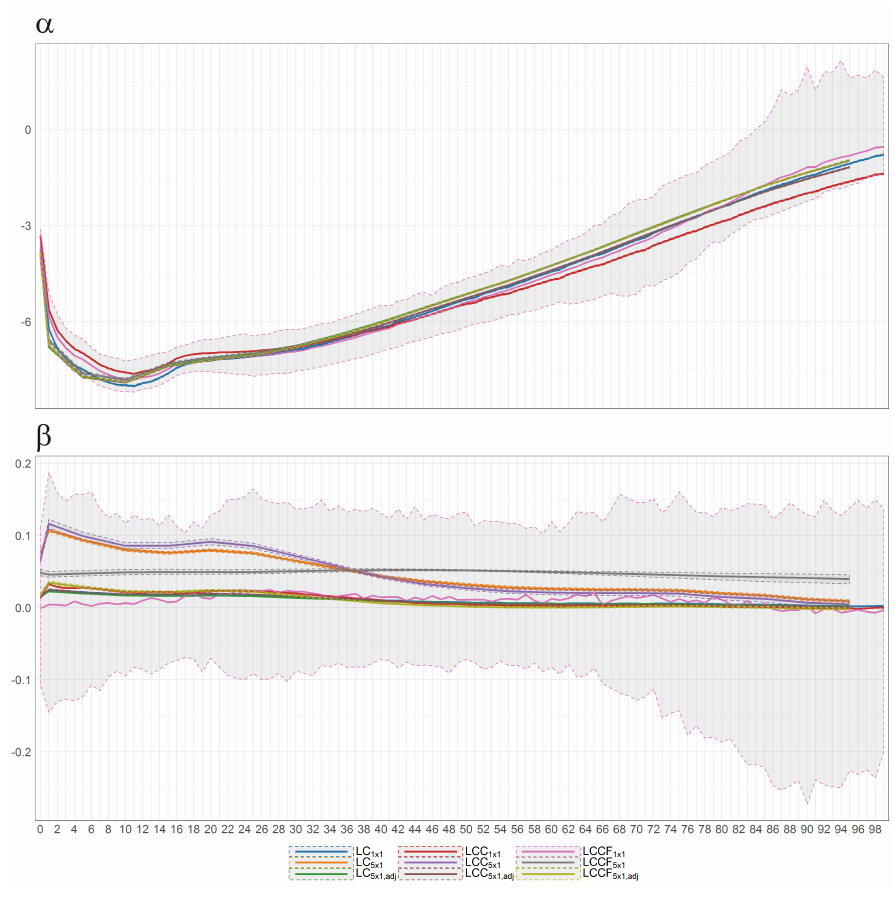
Figure 38. Bayesian posterior estimators with 95% posterior credible intervals for the estimation of α and β under different models (colours of lines) for British female mortality data